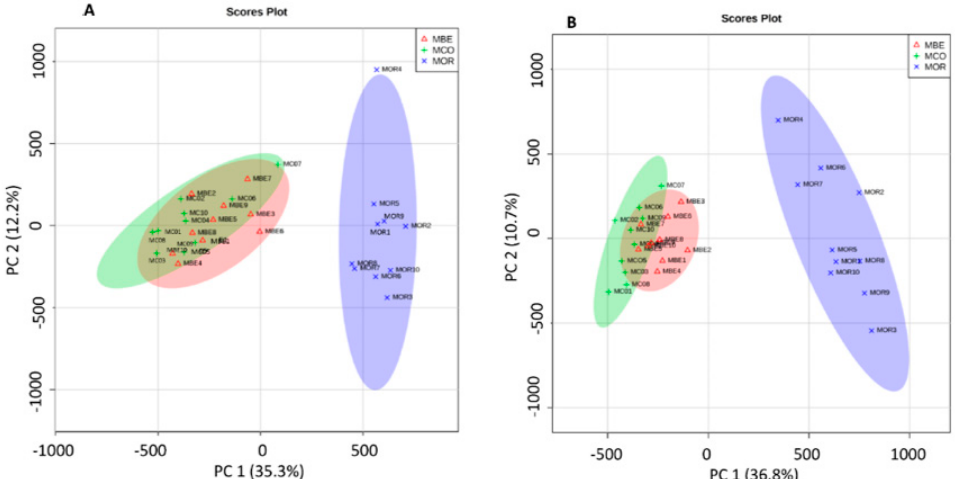
Figure 1. Overview of the three treatments with principal component analysis (PCA). Scores plot of a PCA model from Ophiocordyceps unilateralis -infected (blue, MOR), Beauveria bassiana -infected (red, MBE), and healthy ants’ (green, MCO) muscle samples. ( A ) PCA plot showing the clustering of three di ff erent treatment samples from positive ion MS / MS feature data. ( B ) PCA plot showing the clustering of three di ff erent treatment samples from negative ion MS / MS feature